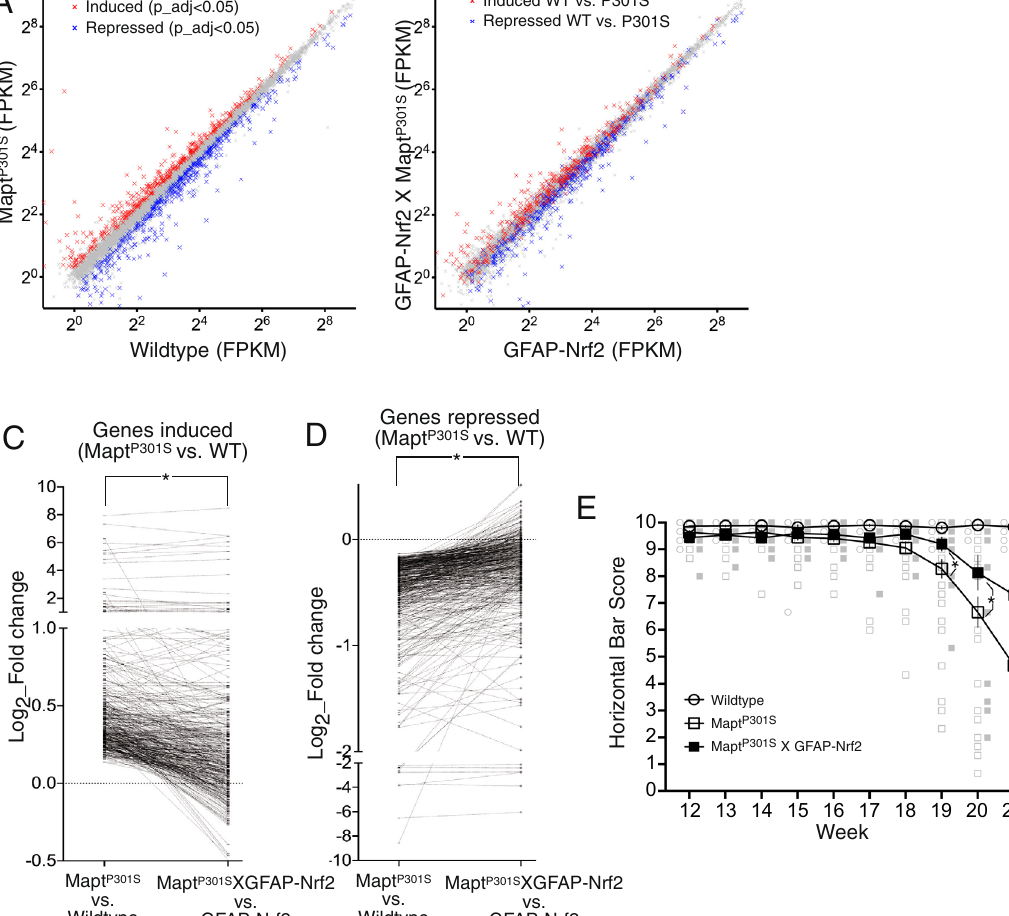
Fig. 6 Astrocytic Nrf2 slows transcriptional perturbation and physical deterioration of the MAPT P301S mouse. A RNA-seq analysis of the early-stage neocortex (MAPT P301S vs WT). Genes induced (red) and repressed (blue) are highlighted (>1FPKM, Benjamini – Hochberg-adjusted p value (p_adj)<0.05); n = 4 animals per genotype. B RNA-seq analysis of early-stage neocortex (MAPT P301S _X_GFAP-Nrf2 vs. GFAP-Nrf2). Genes induced (red) and repressed (blue) from A are highlighted; n = 4 animals per genotype. C , D A comparison of the fold change in gene expression caused by MAPT P301S expression in an otherwise WT background (i.e. MAPT P301S vs. WT) compared to the fold change in gene expression caused by MAPT P301S expression against a GFAP- Nrf2 background (i.e. MAPT P301S vs. MAPT P301S _X_GFAP-Nrf2). Genes induced ( C ) or repressed ( D ) (i.e., genes highlighted in B ) are shown. C Note